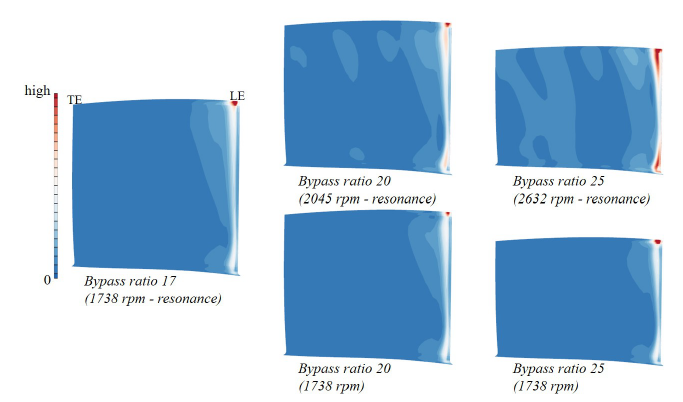
Figure 10. Unsteady pressure amplitude on the suction side with different bypass